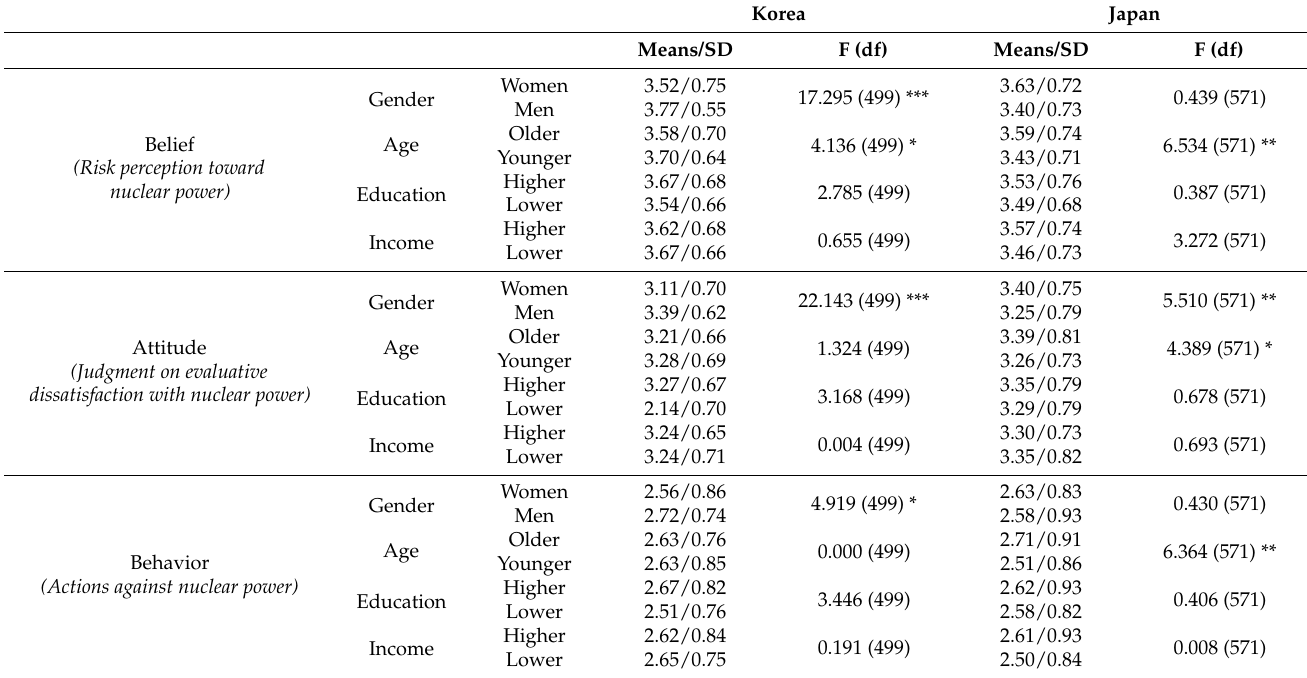
Table 3. ANOVA Test on Belief, Attitude, and Behavior by Gender, Age, Education, and